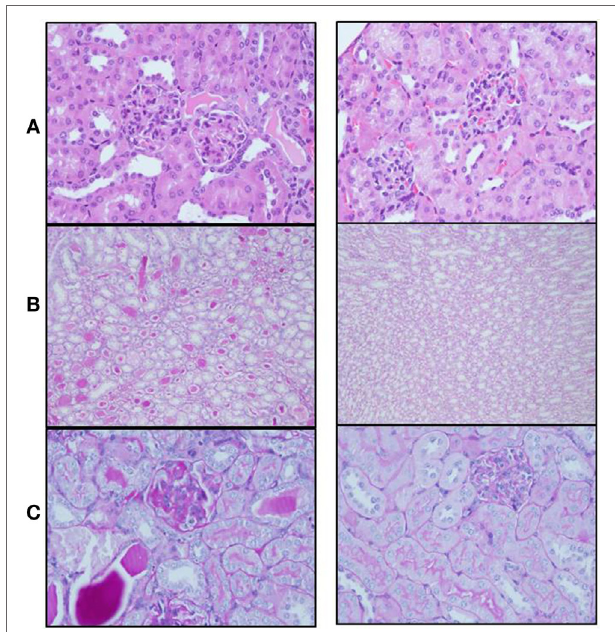
FigUre 2 | (a) Hematoxylin–eosin staining shows paucity of blood capillaries and diffuse mesangial proliferation in control-treated mice (left panel). These findings were minimal in semaphorin3A (sema3A)-treated mice (right panel). (B) PAS staining demonstrates profound glycoprotein deposits in the tubuli of control-treated mice (left panel) and minimal deposits in sema3A-treated mice (right panel). (c) Increased glycoprotein deposits are seen in the mesangium of control-treated mice (left panel) and minimal in sema3A-treated mice (right panel).